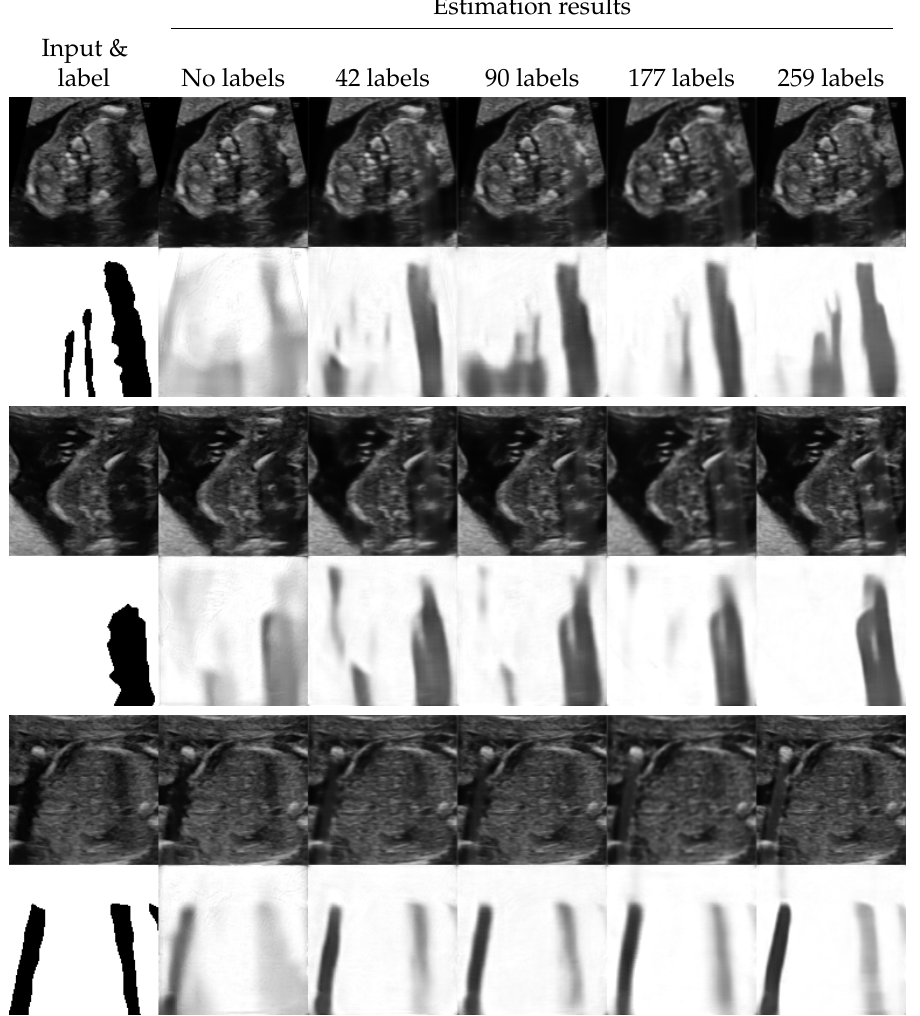
Figure A4. Additional examples of shadow removal results of the proposed method. The lower side of each example shows the labels and the detection results. The upper side shows the input images and the estimated shadow-free